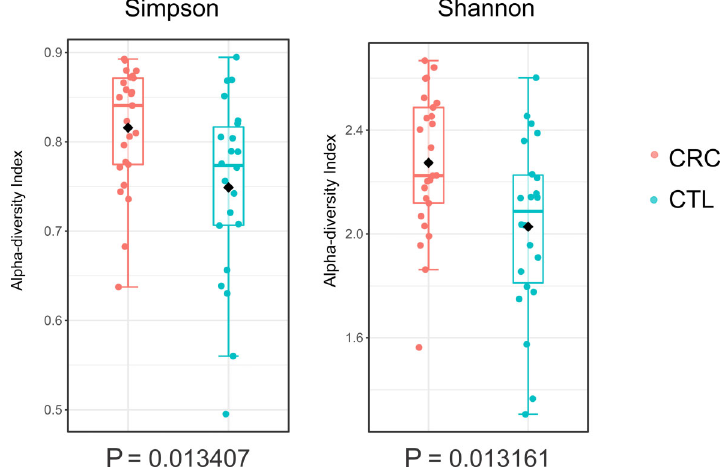
Figure 1. Comparison of alpha diversity of the colorectal adenocarcinoma (CRC) and the control (CTL) groups using the Shannon and Simpson indexes. Boxplots showing the median and interquartile range of each group, and each point corresponds to an individual ’ s alpha diversity. Mann-Whitney U-test.